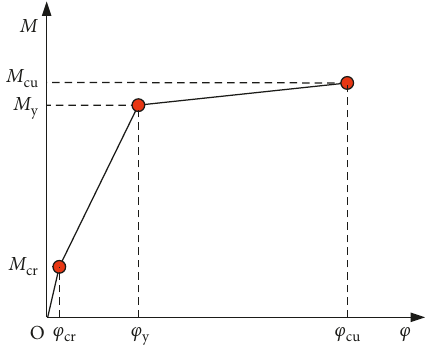
Figure 9: Moment-curvature relationship.